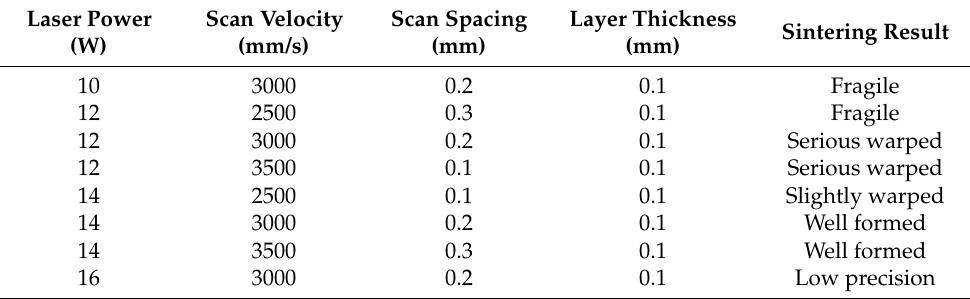
Table 2. Selective laser sintering (SLS) processing parameters for the GF/PF composites.